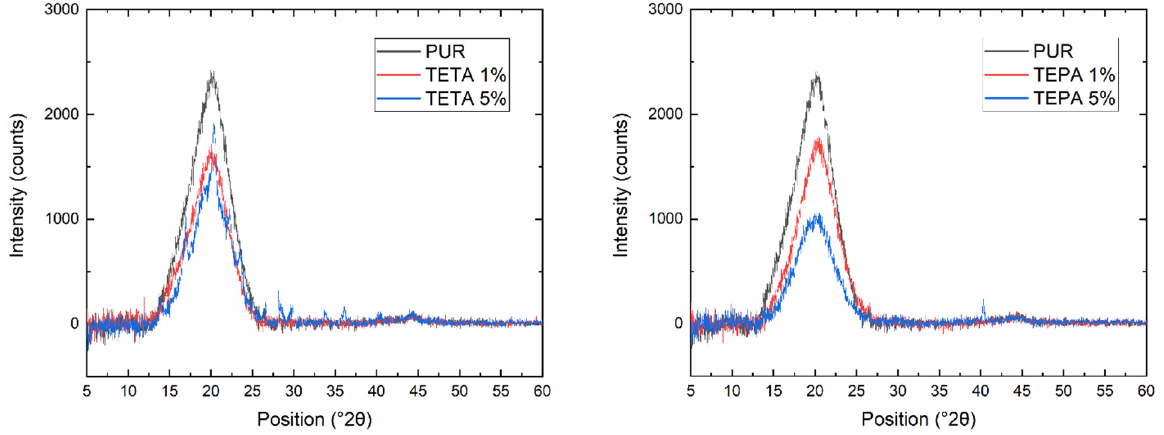
Figure 3. Diffractograms (CuK α ) comparing the structural characteristics of the unmodified PUR membrane with the membranes modified with amines TETA ( left ) and TEPA ( right ).